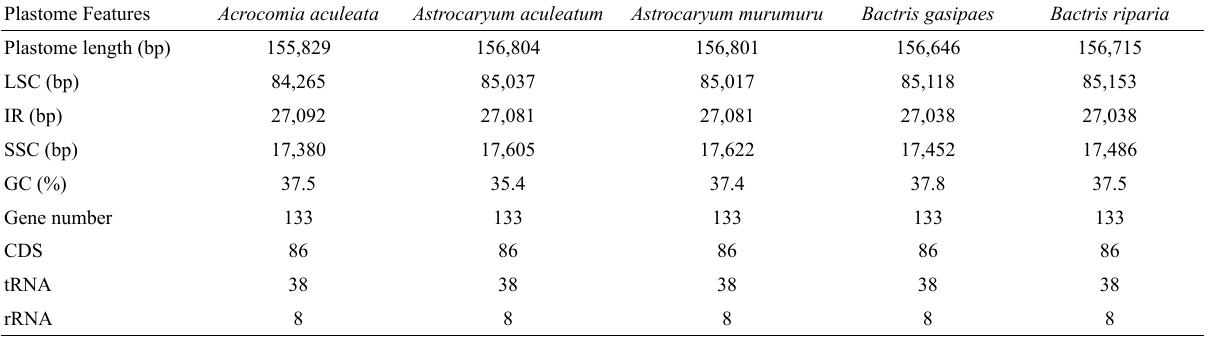
Table 1 – General features of Bactridinae plastid genomes. Plastome